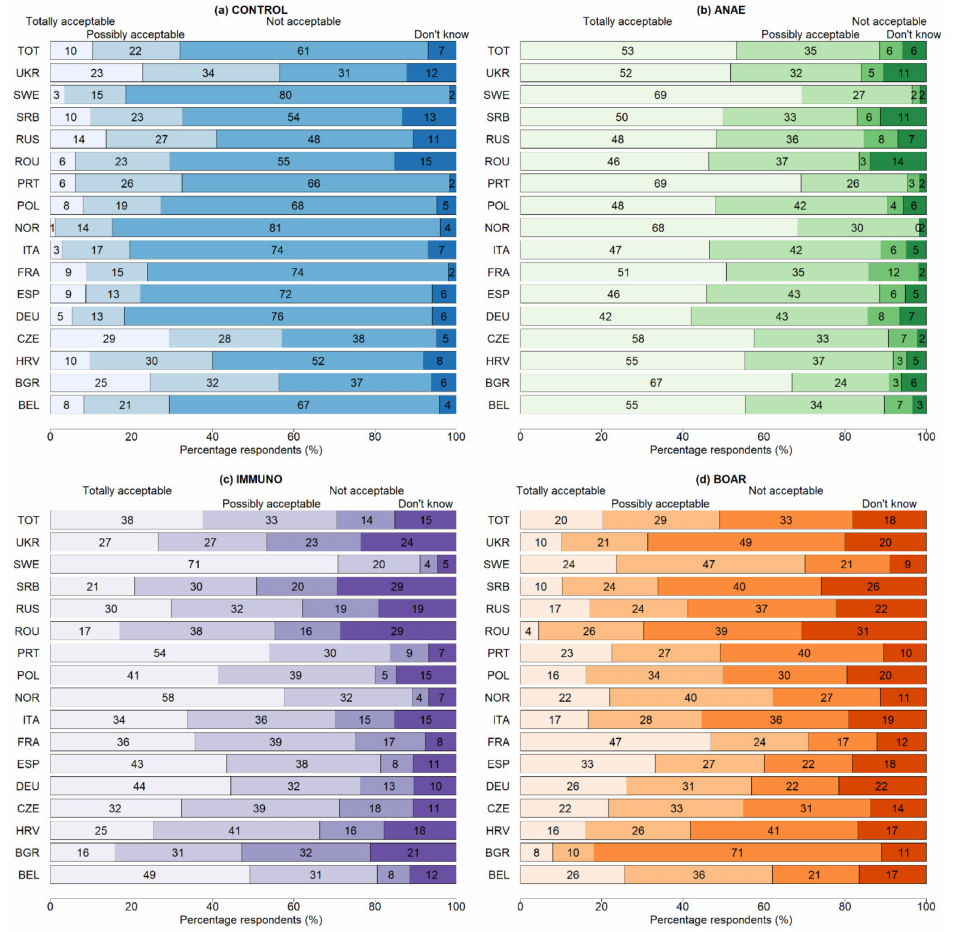
Figure 3. Acceptability of castration alternatives per country for ( a ) Castration without pain relief—CONTROL, ( b ) castration with anaesthesia—ANAE, ( c ) Immunocastration—IMMUNO, ( d ) no castration—BOAR. TOT—total